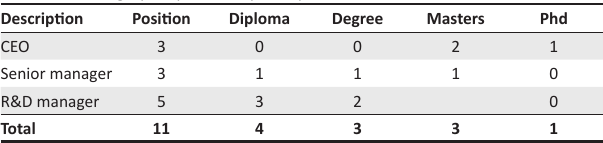
TABLE 1: Demographic profile of